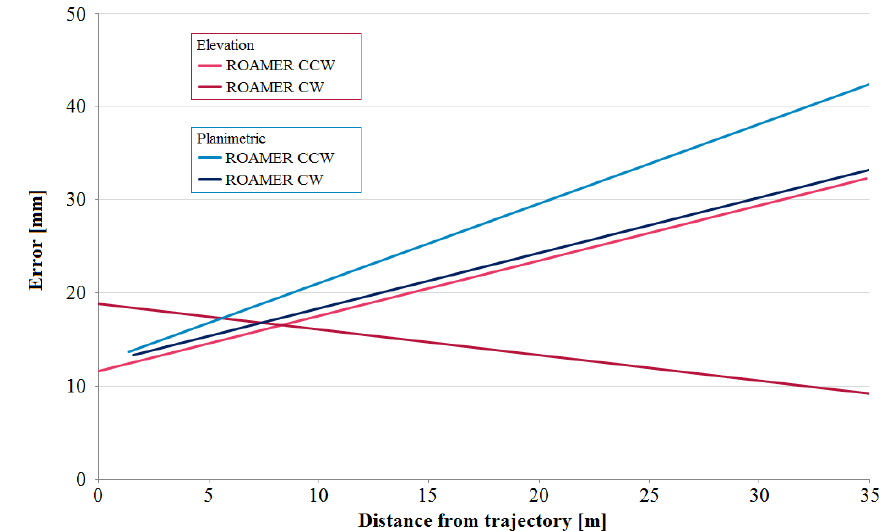
Figure 13. The elevation and planimetric errors as functions of distance from the trajectory for the two driving